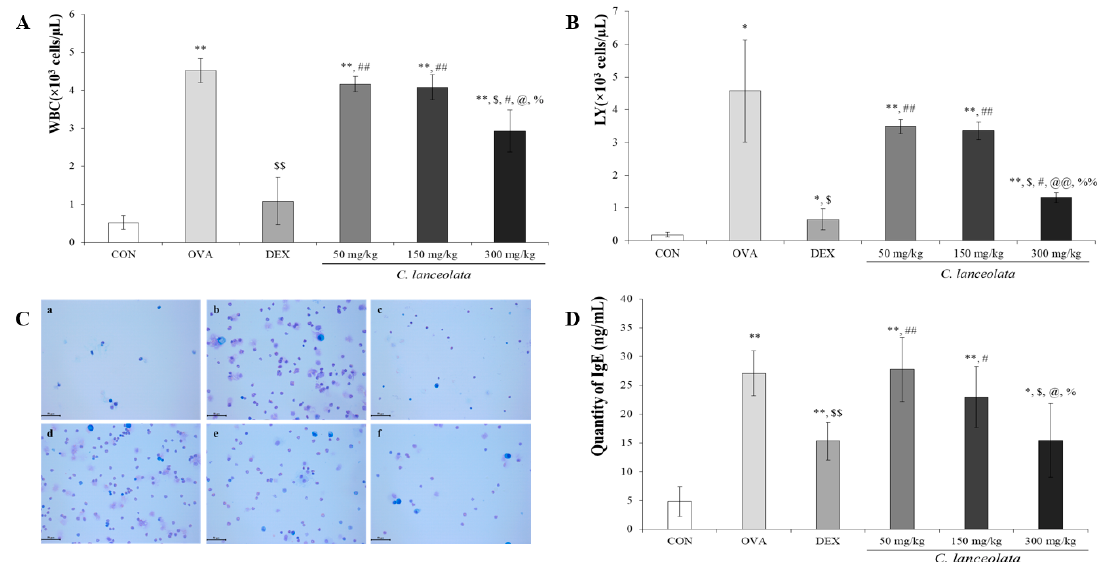
Figure 1. C. laceolata suppressed the population increments of white blood cells (WBC) and lymphocytes (LY) in the bronchioalveolar fluid (BALF) and the quantity of IgE in serum, which were increased by ovalbumin treatment. ( A ) C. laceolata dose-dependently decreased the number of WBC, which was upregulated by ovalbumin. ( B ) The population of lymphocytes was especially decreased by C. laceolata treatment. ( C ) The dose-dependent decrement of inflammatory cells by C. laceolata was observed from the Diff-Quick stain. Scale bar, 50 μ m; magnification, × 400. a, CON; b, OVA; c, DEX, d, 50 mg/kg/day C. laceolata , e, 150 mg/kg/day C. laceolata . f. 300 mg/kg/day C. laceolata . ( D ) C. laceolata dose-dependently decreased the level of serum IgE, which was up-regulated by ovalbumin treatment, and specifically, in the 300 mg/kg/day C. laceolata treatment group, the level of serum IgE was similar to that in the dexamethasone treatment group. CON, vehicle group; OVA, ovalbumin-induced asthma group; DEX, positive control group (1 mg/kg/day dexamethasone with OVA); 50 mg/kg/day C. laceolata , 50 mg/kg/day C. laceolata treated group with OVA; 150 mg/kg/day C. laceolata , 150 mg/kg/day C. laceolata treated group with OVA; 300 mg/kg/day C. laceolata , 300 mg/kg/day C. laceolata treated group with OVA. * p < 0.05 vs. CON; ** p < 0.001 vs. CON; $ p < 0.05 vs. OVA; $$ p < 0.001 vs. OVA; # p < 0.05 vs. DEX; ## p < 0.001 vs. DEX; @ p < 0.05 vs. 50 mg/kg/day C. laceolata ; @@ p < 0.001 vs. 50 mg/kg/day C. laceolata ; % p < 0.05 vs. 150 mg/kg/day C. laceolata ; %% p < 0.001 vs. 150 mg/kg/day C. laceolata.